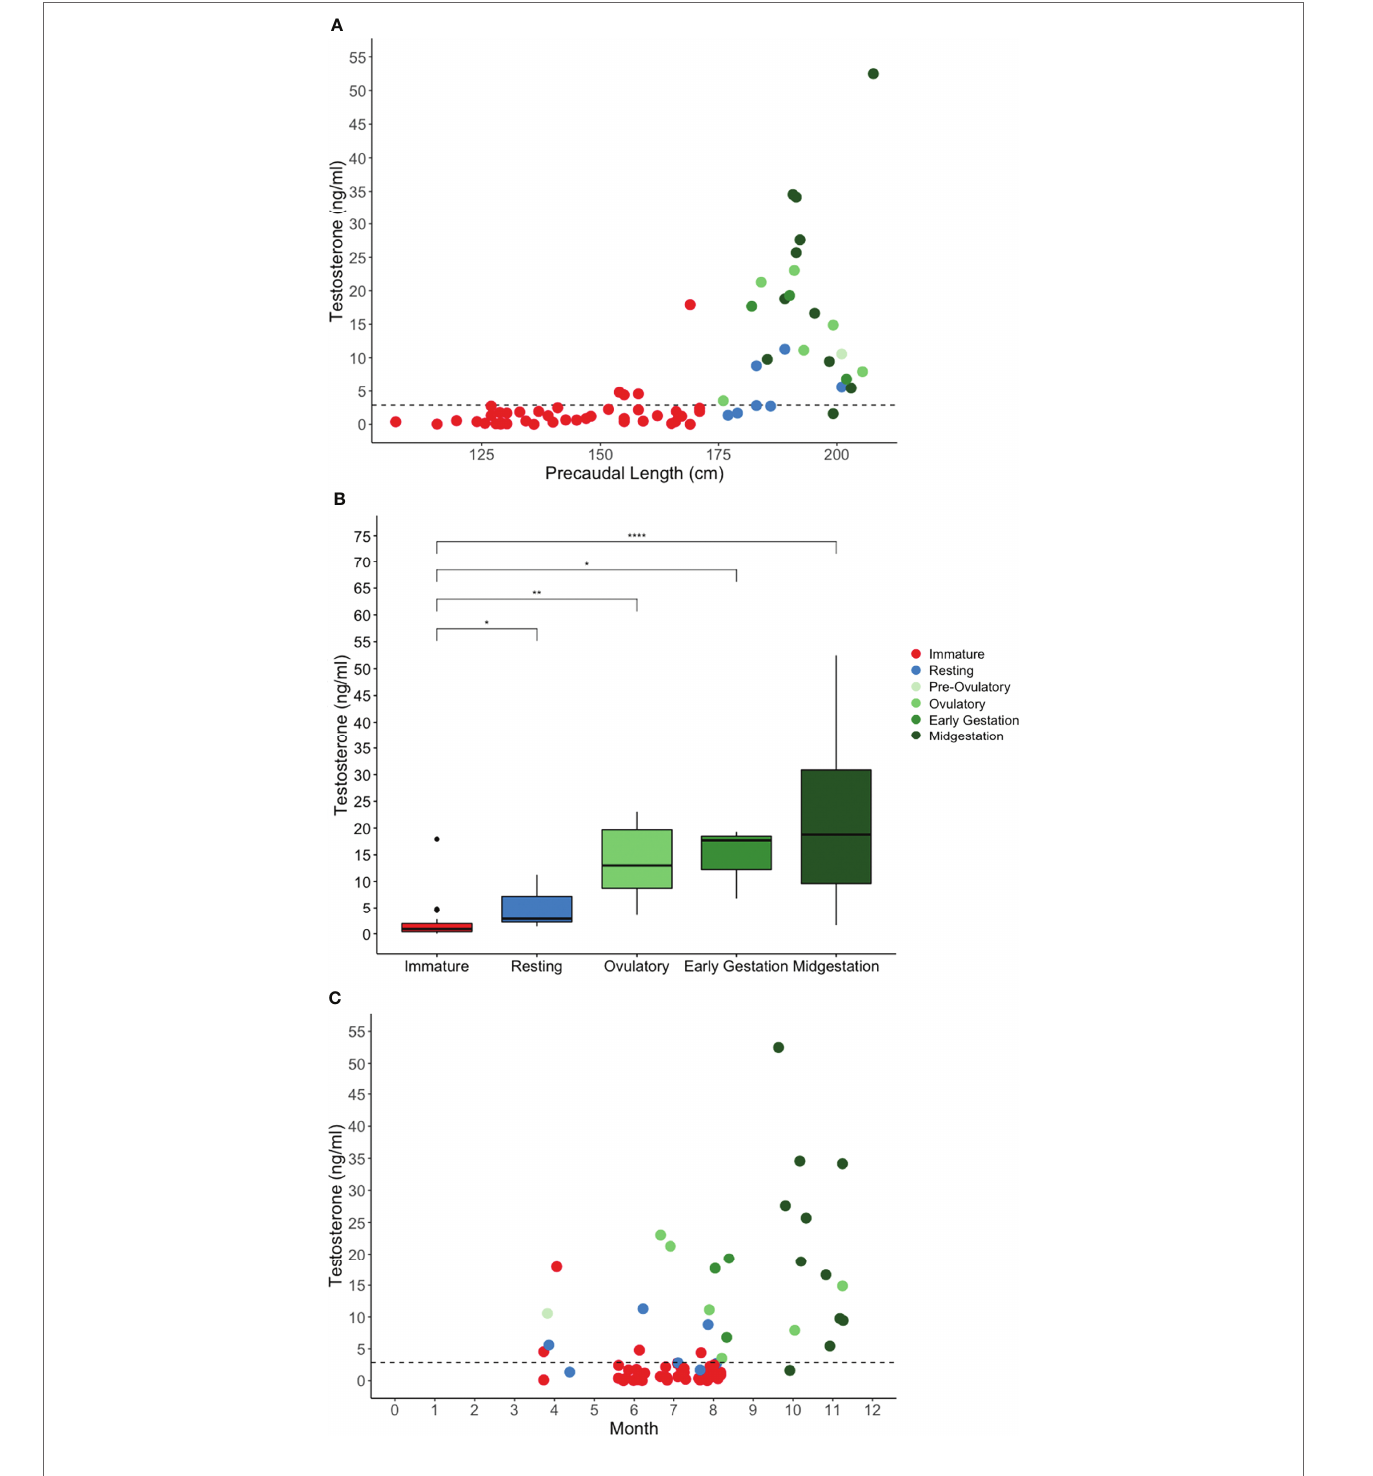
FIGURE 4 | Plasma testosterone concentration by (A) shark length, (B) reproductive stage, and (C) month for in situ sand tiger sharks. Color indicates reproductive stage and the dotted line represents the threshold for elevated hormone concentration. There was a significant difference between immature and resting (* P = 0.0443), ovulatory (** P = 0.00107), early gestation (* P = 0.0161) and midgestation (**** P <.0001) stages. Testosterone concentration was highest in the fall, associated with gestational